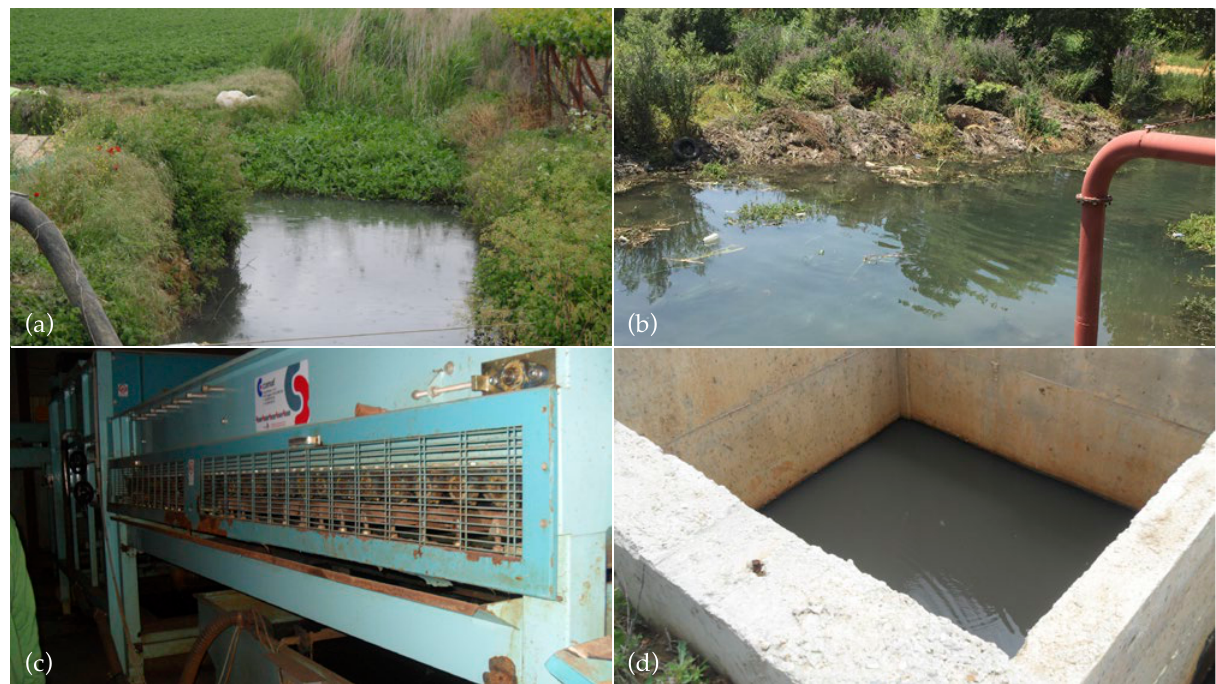
Figure 3. Examples of sites for monitoring the possible presence of Rsol : Irrigation canal (a) and irrigation basin (b) near potato fields, where surface water was sampled. Potato washing machines (c), where potatoes are washed prior to storage, and where water samples were taken for analyses. Waste water container (d), located just outside a potato processing fac- tory, where waste water was collected for